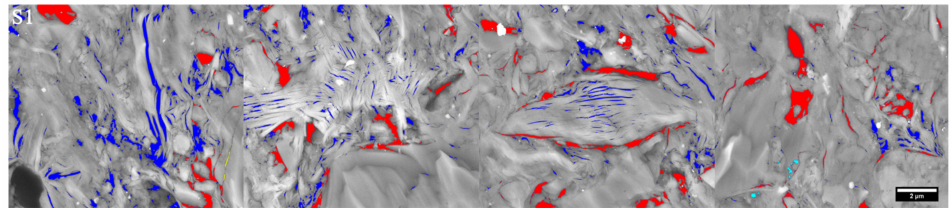
Figure 3. Pore identification in argillaceous shale. Red represents interparticle pores, blue represents intraparticle pores, cyan represents dissolution pores.